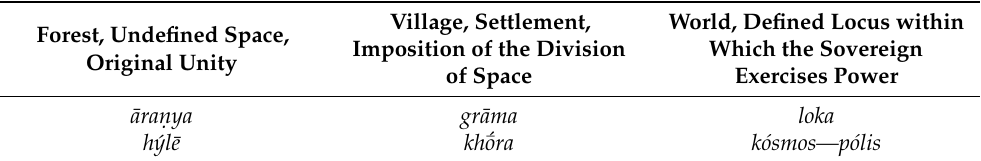
Table 2. The world and the forest in early Buddhism compared with possible analogous Greek conceptions. Village, Settlement, World, Defined Locus within Forest, Undefined Space, Imposition of the Division Which the Sovereign Original Unity of Space Exercises Power ¯aran. ya gr¯ama loka